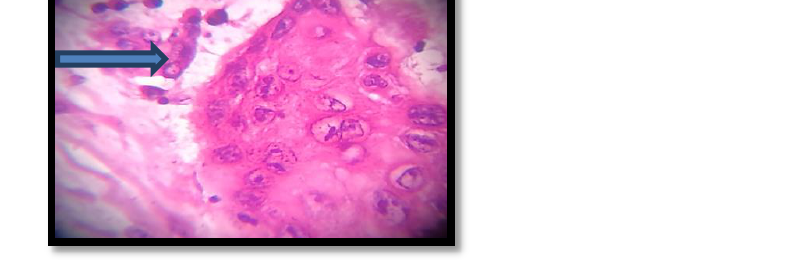
Figure 3: (x400): Histological section of well differentiated squamous cell carcinoma with low stromal eosinophilia showed only one eosinophil (arrow) in this high power field